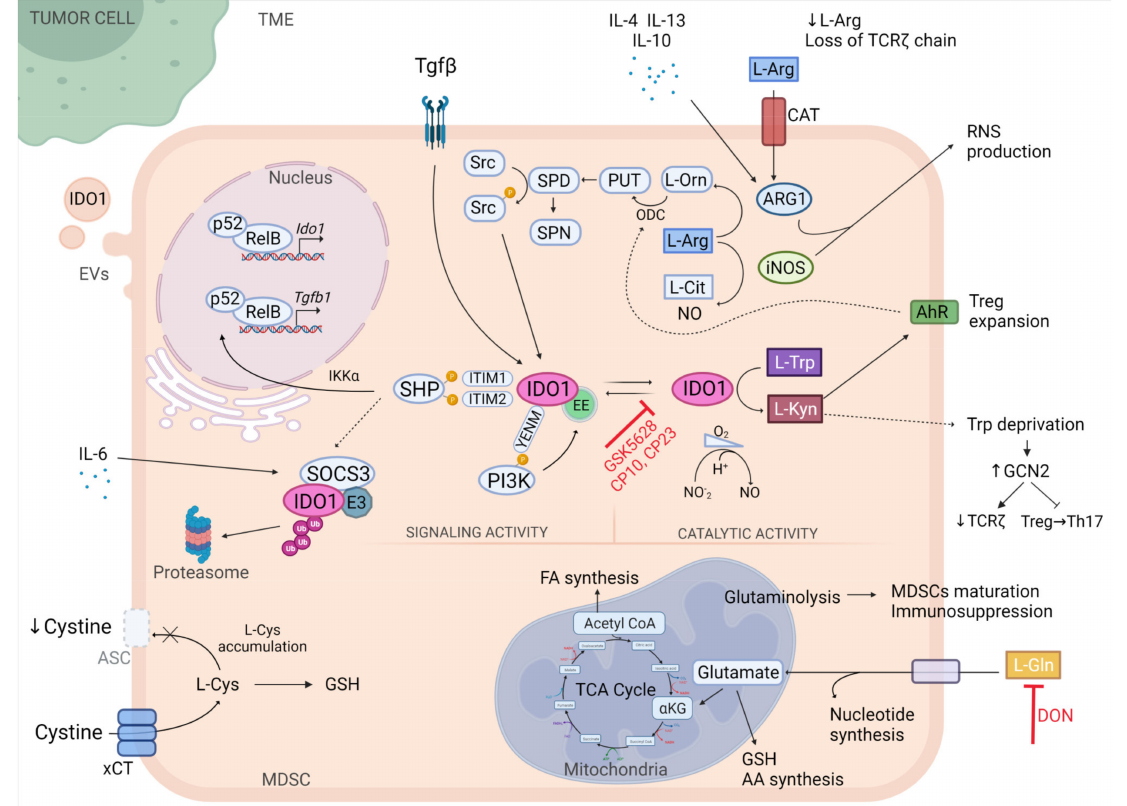
Figure 2. Metabolic conversion of amino acids contributes to the immunosuppressive role of MDSCs. L -arginine ( L -Arg) is converted into urea and L -ornithine ( L -Orn) by arginase-1 (Arg1), and into L -Citrulline ( L -Cit) and nitric oxide (NO) by inducible nitric oxide synthase (iNOS). L -Orn is further metabolized by ornithine decarboxylase (ODC) into polyamine (PUT, putrescine; SPD, spermidine; SPN, spermine). SPD promotes the phosphorylation of indoleamine 2,3-dioxygenase 1 (IDO1) through the activation of the Src kinase. Once phosphorylated, IDO1 recruits Src homology region 2 domain-containing phosphatase (SHPs) and phosphoinositide 3-kinase (PI3K), triggering the non-canonical NF-kb pathway and